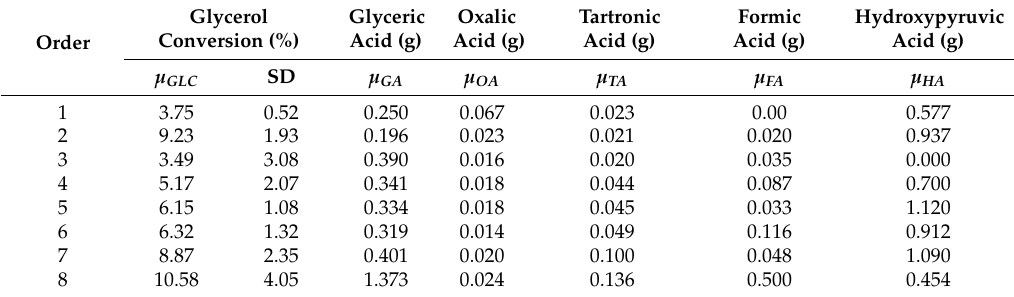
Table 4. Glycerol conversion and amount of oxidative products formed for the 30-min as-deposited electroless CuNiMoP/Al 2 O 3 catalyzed oxidations.